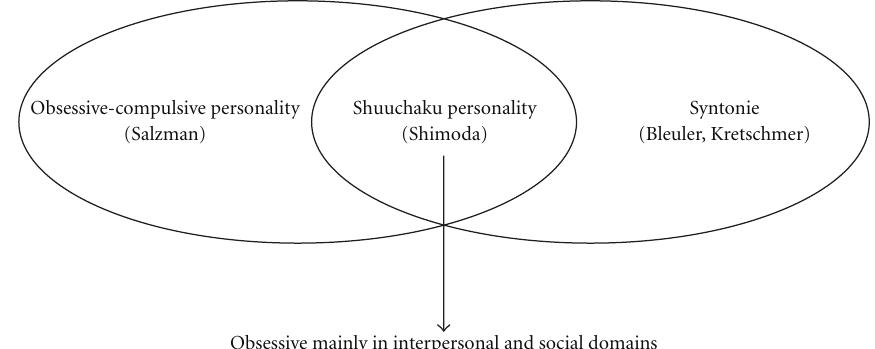
Figure 1: Obsessive-compulsive personality (Salzman), Shuuchaku personality (Shimoda), and Syntonie (Bleuler,